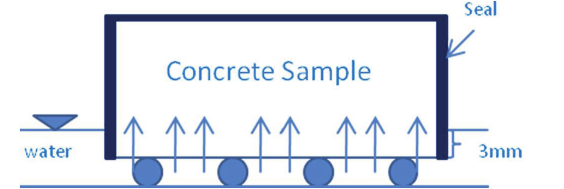
Fig. 3. Schematic of chloride ion diffusion